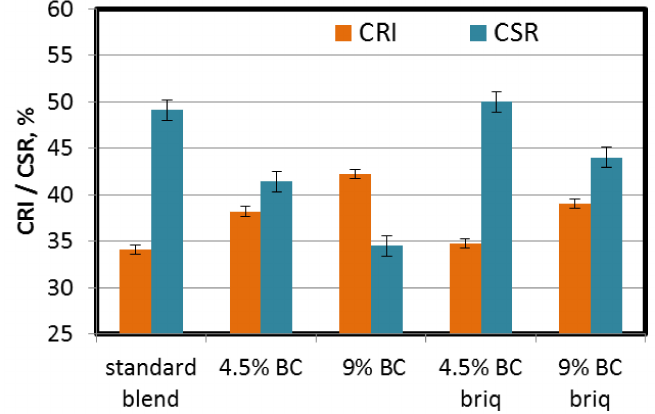
Figure 10. Influence of lignite addition on coke reactivity index (CRI) and coke strength after reaction (CSR) of